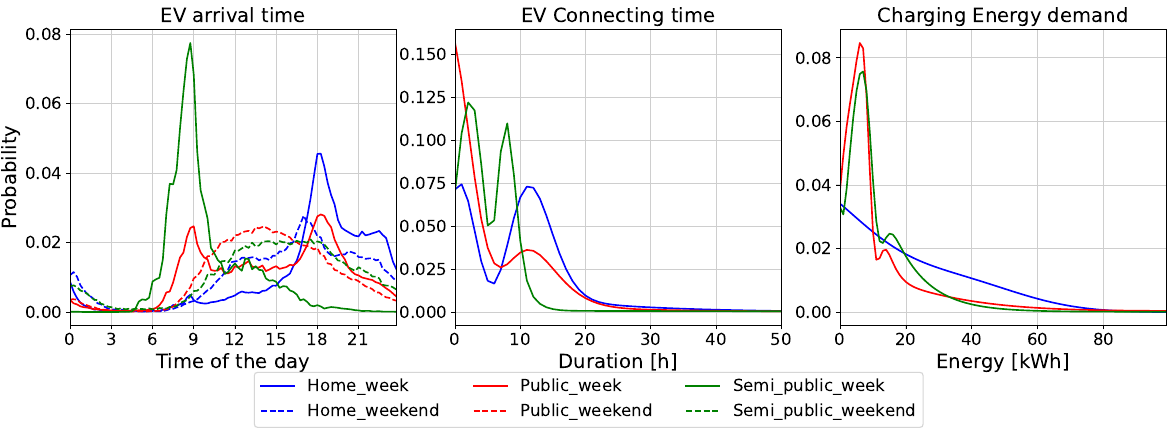
Figure 5. EV behaviour distribution curves. ( Only EV arrival time has weekday–weekends differ- ences; the other two have the same distribution throughout the whole